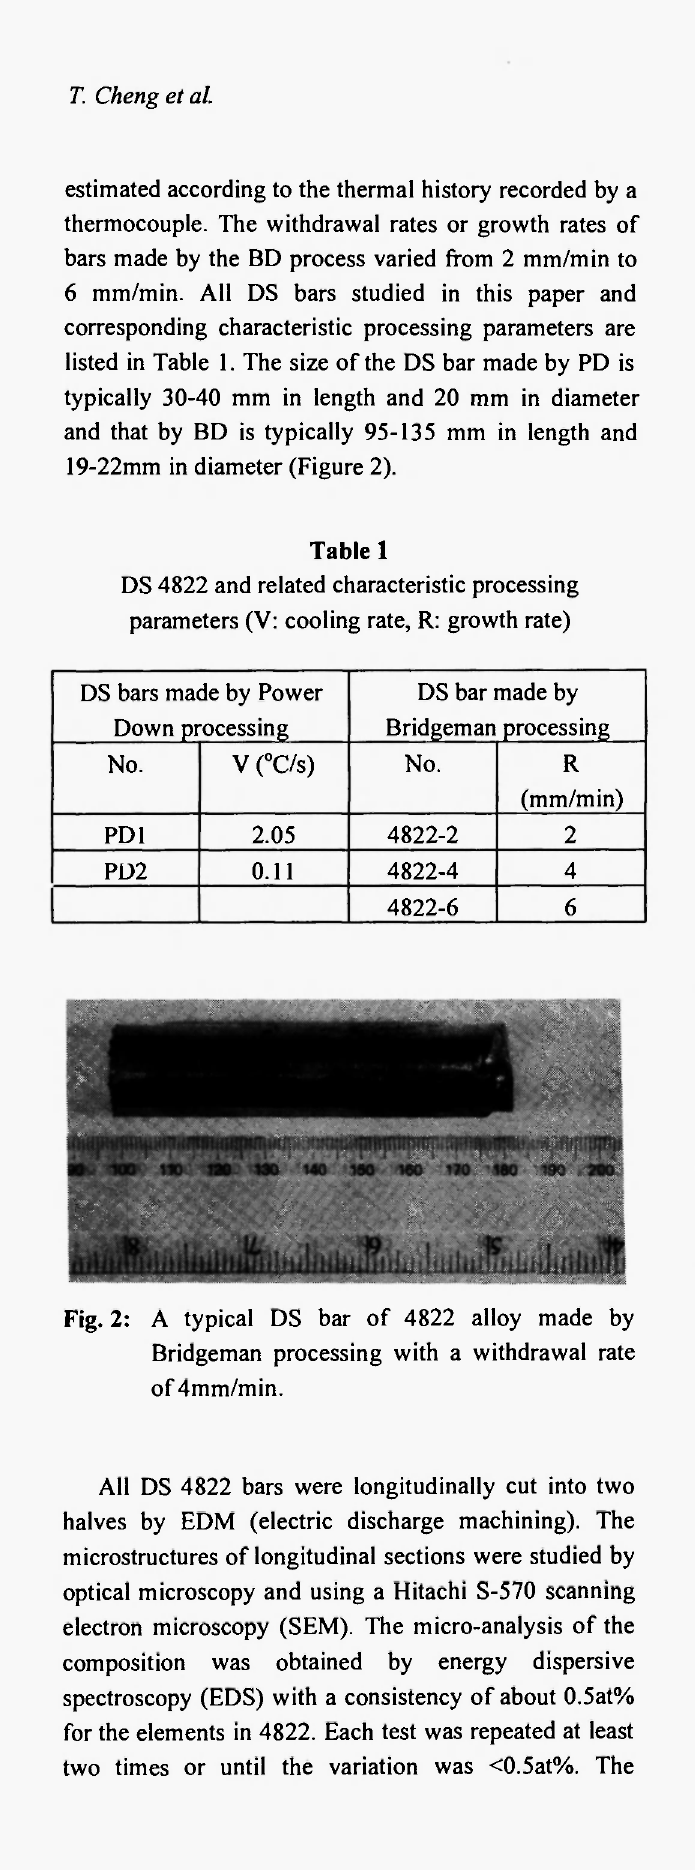
DS 4822 and related characteristic processing parameters (V: cooling rate, R: growth rate)